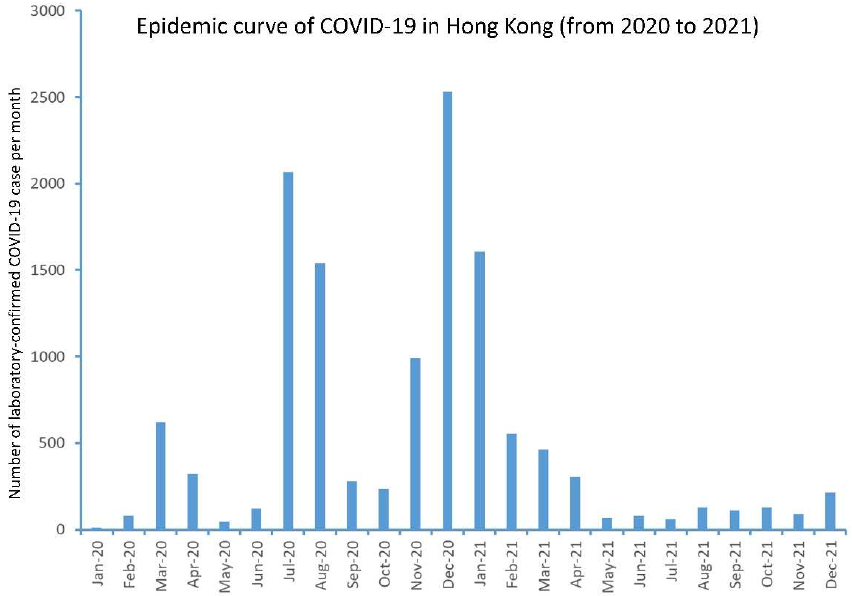
Figure 1. Epidemic curve of laboratory-confirmed COVID-19 cases in Hong Kong (from 2020 to 2021).